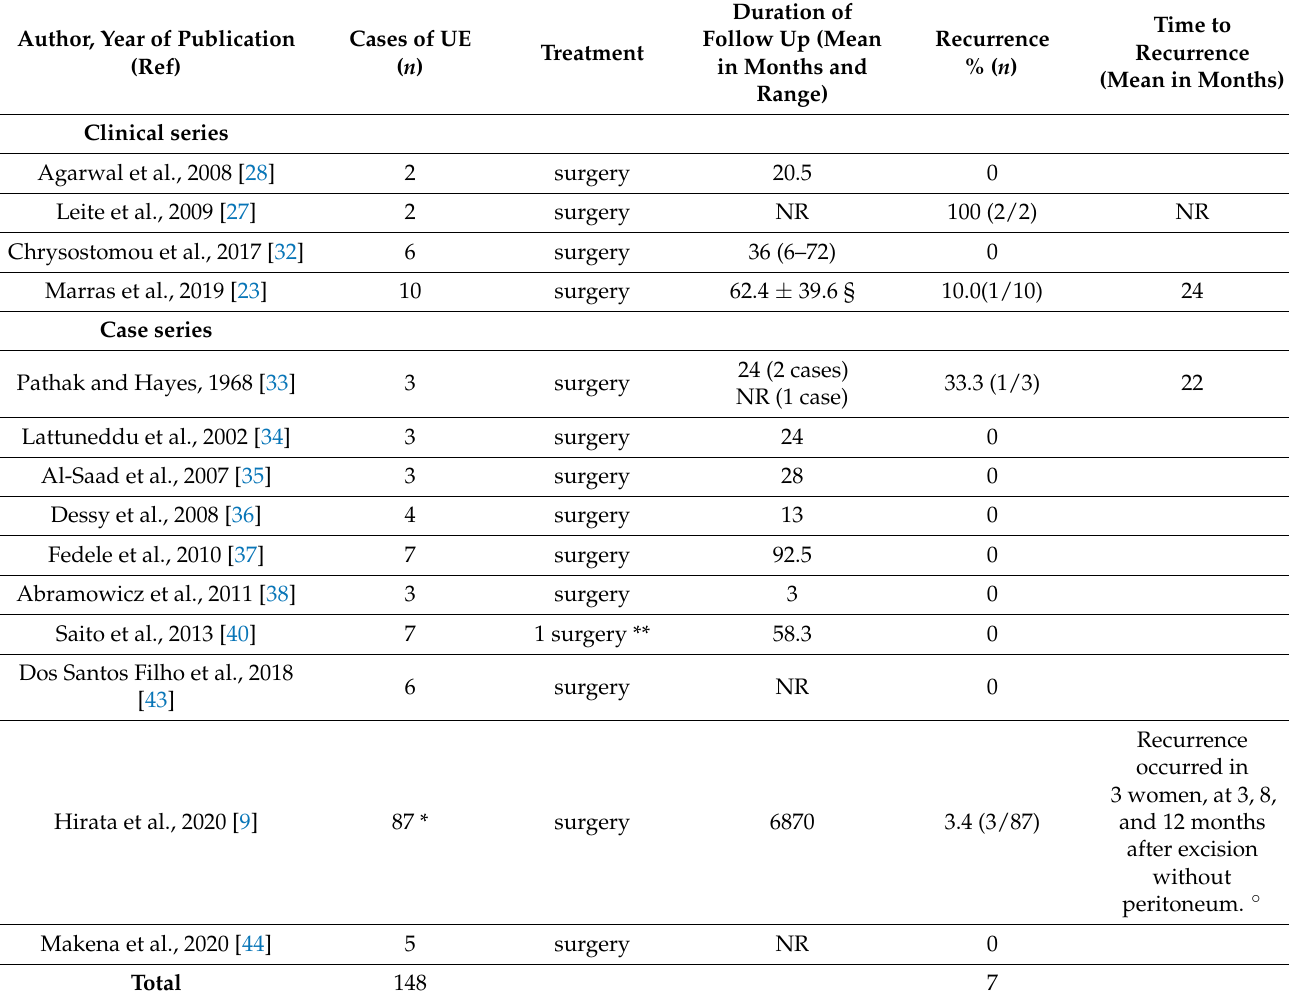
Table 4. Frequency of recurrence of